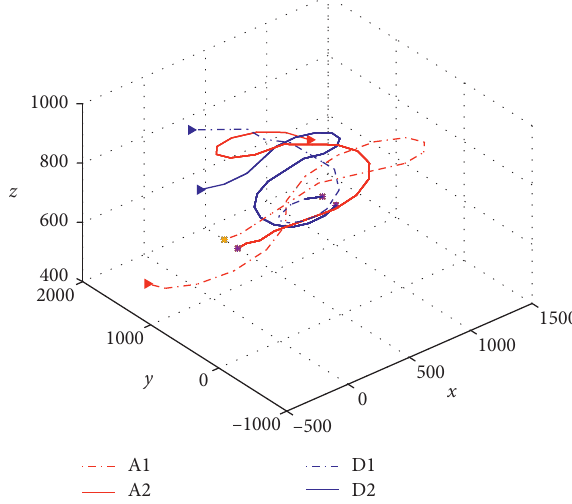
Figure 7: Multi-UUV cooperative dynamic maneuver decision-making: stage